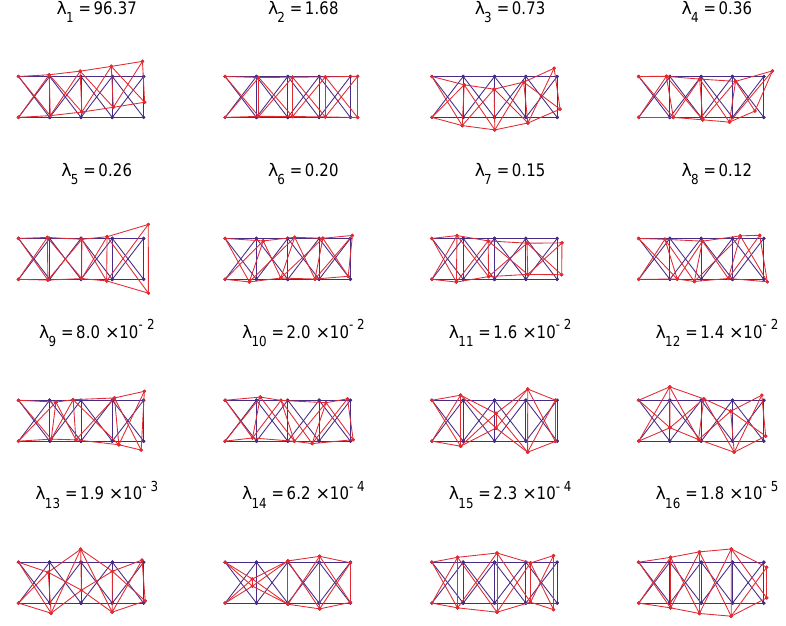
Fig. 3. Proper orthogonal modes with respective mean energies for impulsive forces applied at node 10 in both